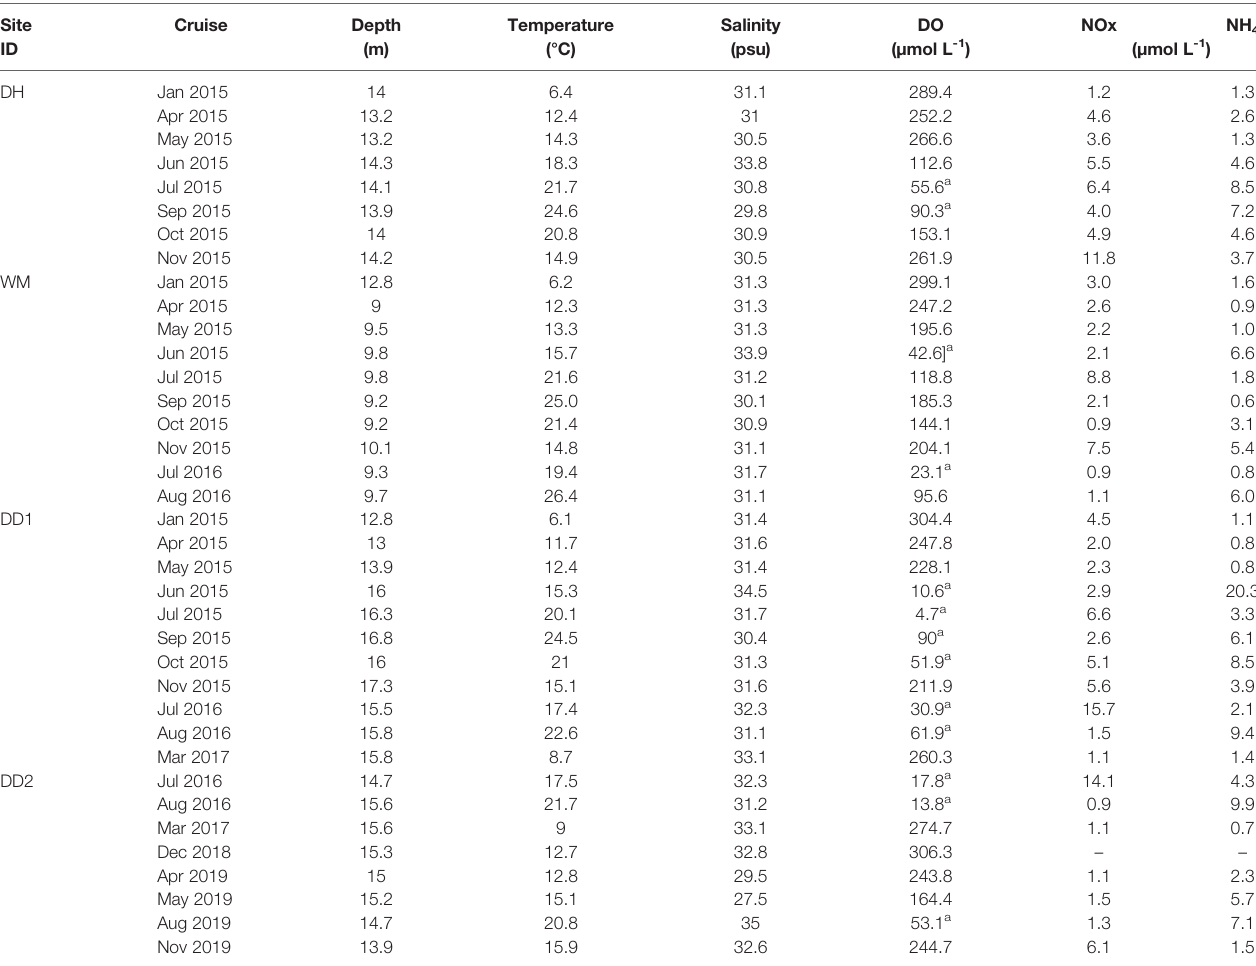
TABLE 1 | Ambient bottom water (approximately 0.5 m above sediment surface) conditions at sites sampled on cruises in Jinhae Bay. Site Cruise Depth ID